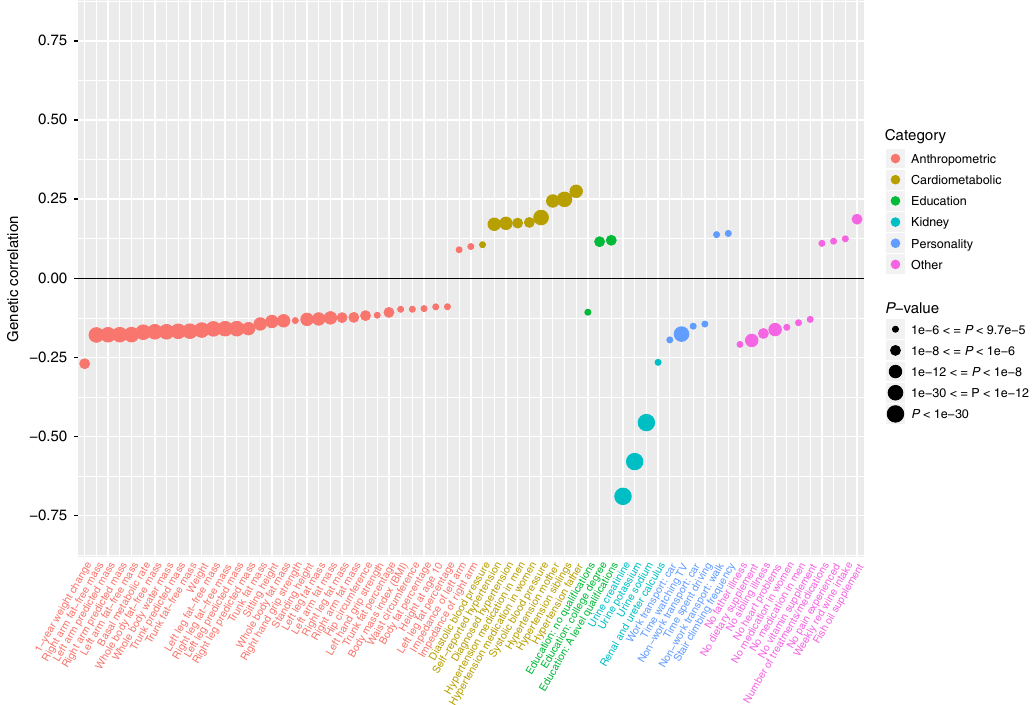
Fig. 4 Genetic correlation of urinary albumin-to-creatinine ratio (UACR) with other traits and diseases. Signi fi cant ( p < 9.7 × 10 − 5 ) genetic correlations based on the genome-wide summary statistics from the EA UACR GWAS and 517 pre-computed and publicly available GWAS summary statistics of UKBB traits and diseases, available through LDHub. Traits are shown on the x -axis, and colored according to broad physiological categories. Genetic correlations between traits and UACR are reported on the y -axis. Dot size is proportional to the – log 10 ( p ) of the corresponding genetic